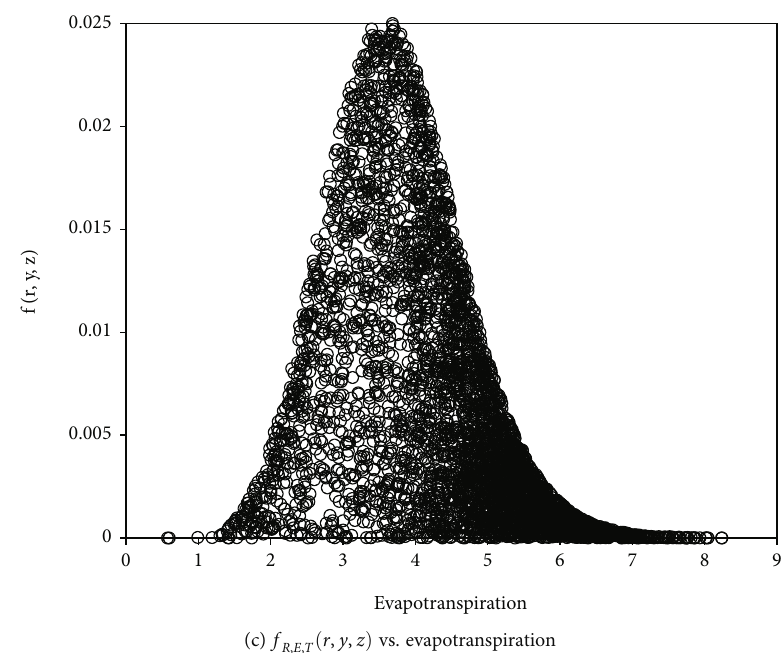
r , y , z Þ estimated from conditioning. Figure 11: f R , E , T ð